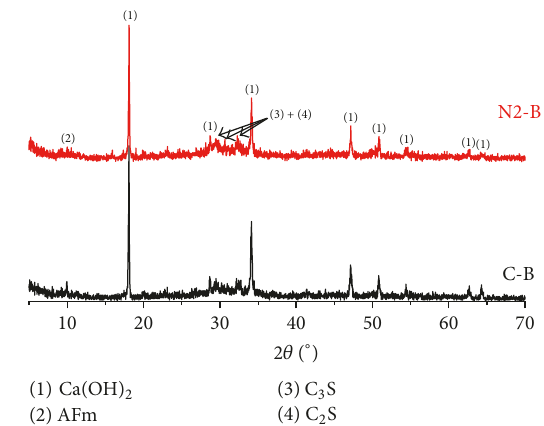
Figure 6: XRD patterns of the standard-cured paste at the age of 90 d.